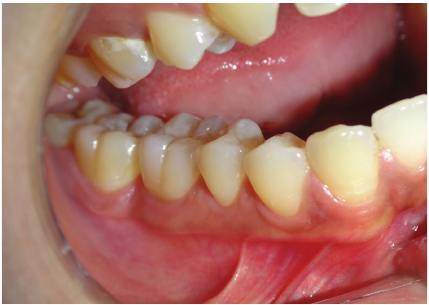
Figure 3: Indentation of elastic band on interdental papilla after its removal.